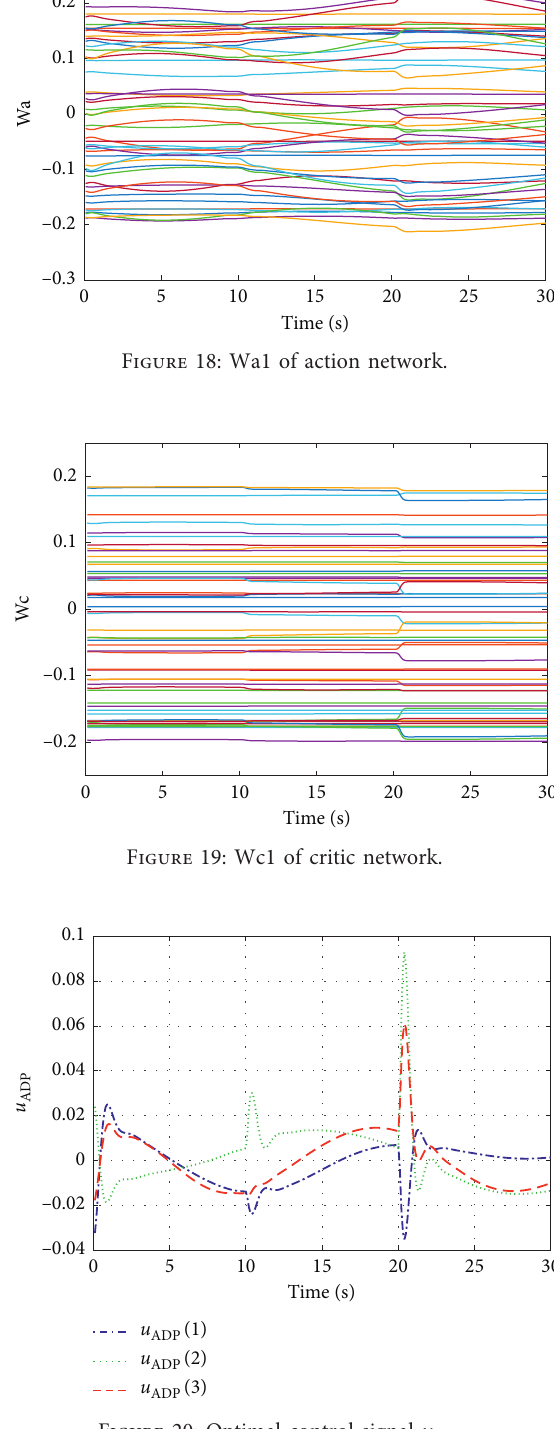
Figure 20: Optimal control signal u